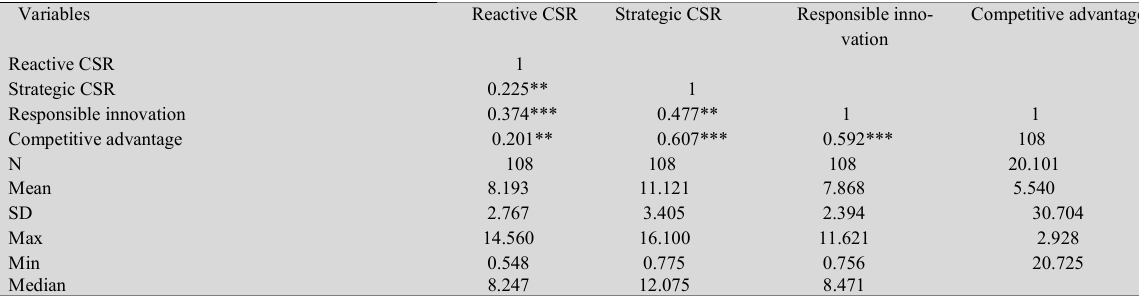
Pearson's correlation and summary statistics.